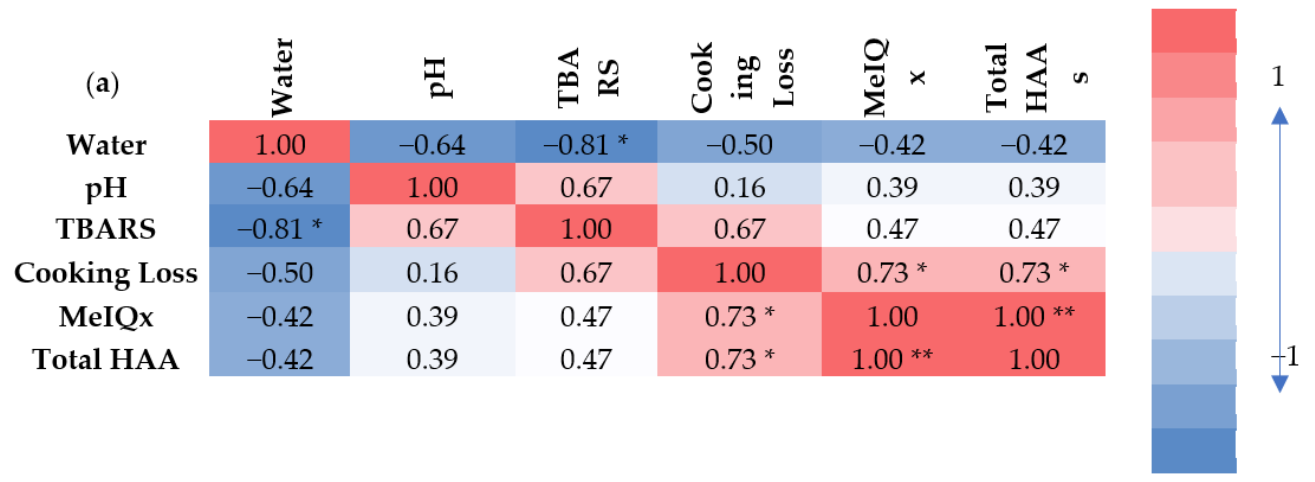
Figure 1. Correlation between water, pH, TBARS, cooking loss, and the formation of HAAs. *: p < 0.05; **: p < 0.01.